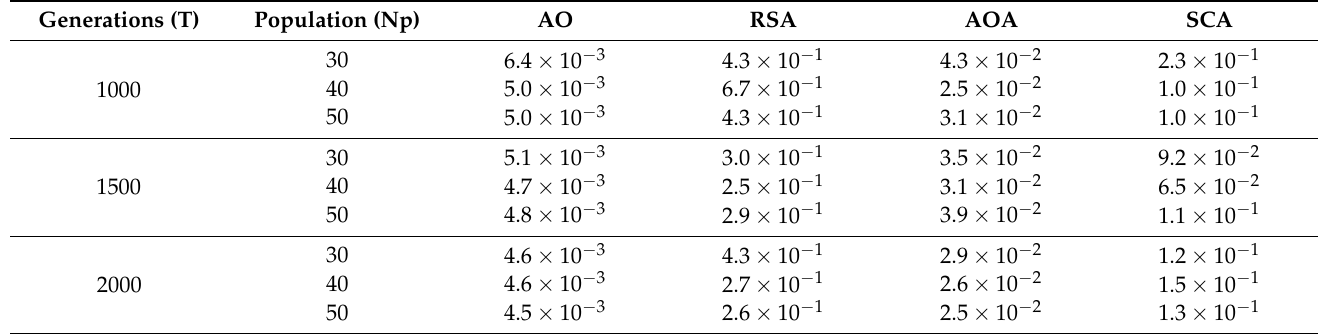
Table 20. Comparison of AO with RSA, SCA, and AOA against average fit for the CAR model at 0.08 noise